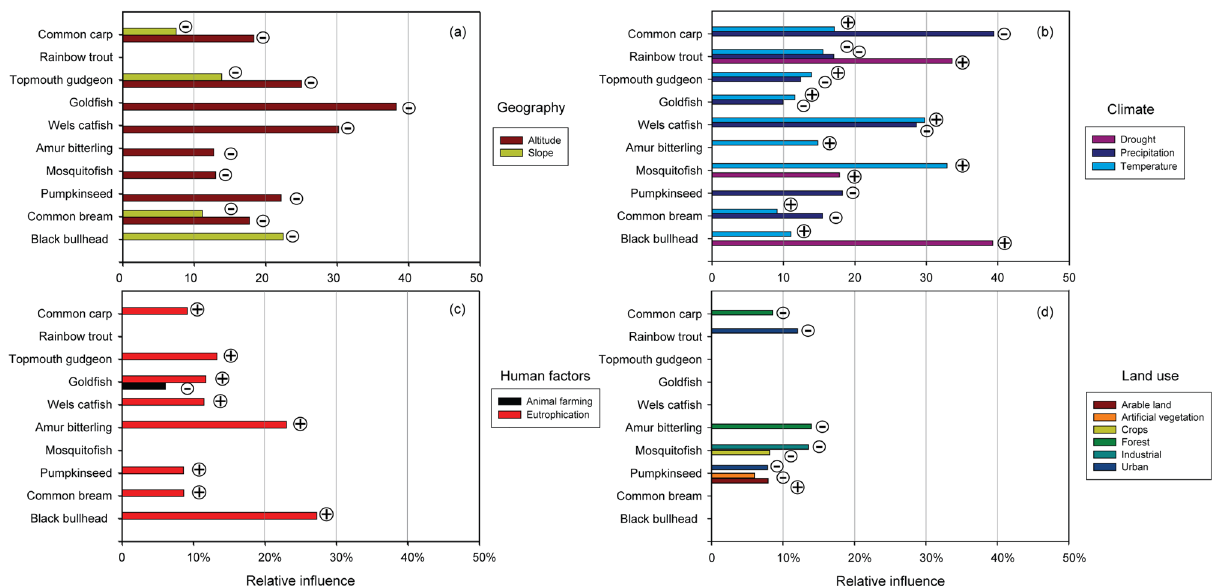
Figure 5. Relative influence of each driver (and drivers group) on the distribution and prevalence in the community of the top 10 invasive freshwater fish in Italy (listed in descending order of invasiveness, from the top), as derived from BRT analysis. Pluses ( ⊕ ) and minuses ( ⊖ ) on the right of each bar represent the direction of the influence (positive and negative, respectively). On average, SAC explained 28.7% of the variation for each species. See Supplementary Fig. 3 for additional details on the response variation of each species through the driver